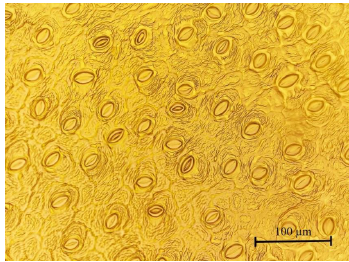
Figure 3. Sample of the stomatal features of the leaves of Hebe at × 400 magnification (abaxial surface). The leaves in SL5 had a lower chlorophyll content compared to the control (10% lower), while SL3 had no different chlorophyll content than the control (Table 3). Salinity is known to accelerate the degradation of leaf chlorophyll and reduce chlorophyll synthesis rates, resulting in leaf yellowing or necrosis [47]. Niu et al. [48] observed a significant decrease in relative chlorophyll content (SPAD) in leaves of several species with increasing salinity. However, no chlorosis or apical burns were observed in the leaves of SL5 plants, which maintained their visual quality. Reductions in chlorophyll content under salinity have been related to salt-sensitive species in other studies